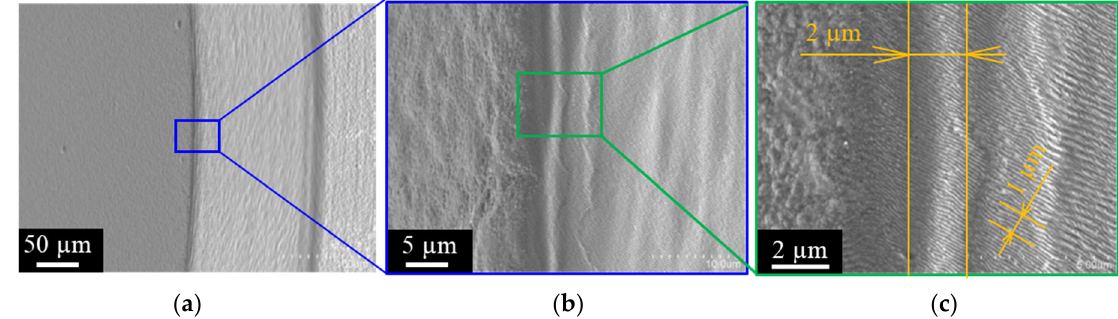
Figure 2. SEM image on the punch head and side surfaces of trimmed diamond-coated punch across the punch edge with various magnifications. ( a ) Overall view of the trimmed, diamond-coated punch, ( b ) Higher magnification image on the punch edge, and ( c ) Highest magnification image on the vicinity of the edge.